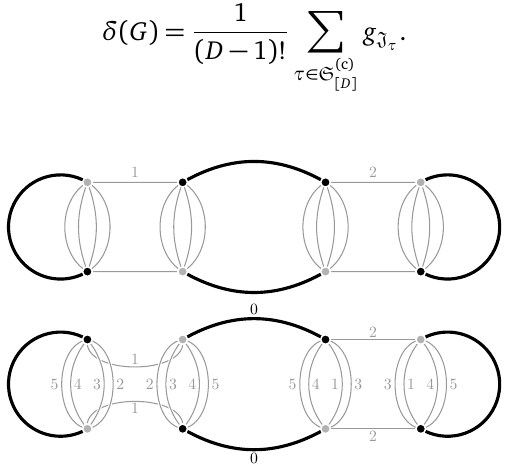
Figure 3: The jacket J (